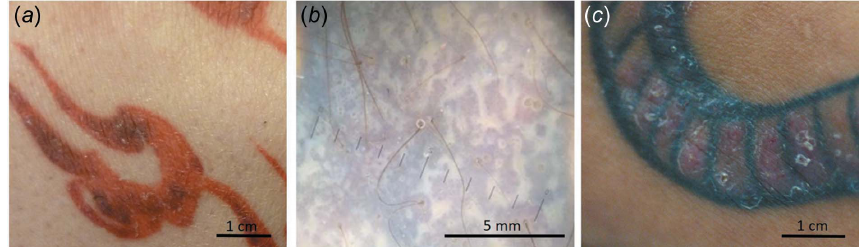
Figure 1 Clinical presentations of skin reactions on tattoo. ( a ) Patient 1, presenting a papular eruption on a red tattoo. ( b ) Patient 9, presenting a lichenoid eruption on a black tattoo (picture taken using a dermatoscope). ( c ) Patient 10, presenting a papular eruption on a black